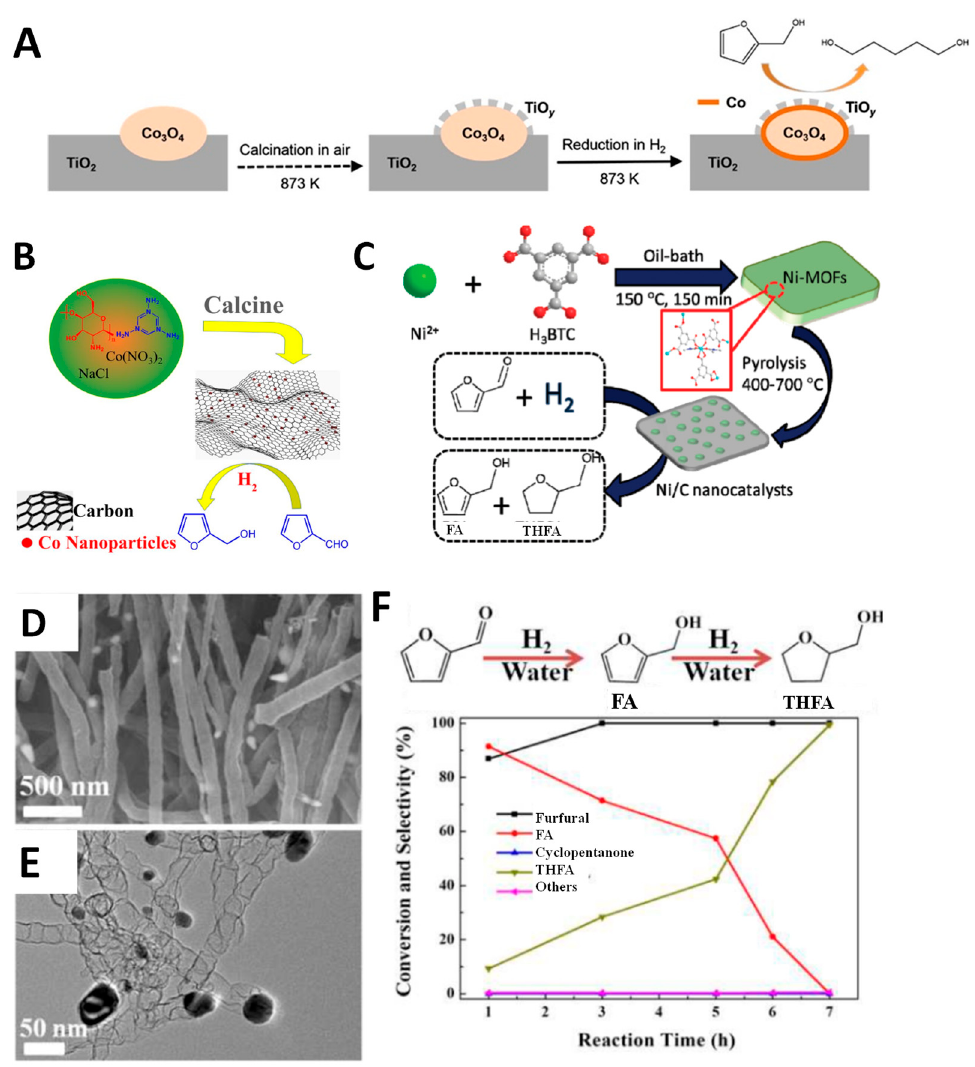
Figure 4. ( A ) Schematic illustration of the synthetic approach for Co / TiO 2 catalyst and its application in furfural hydrogenation. Reprinted with permission from [138]. Copyright 2015 Elsevier. ( B ) Co based catalyst over nitrogen-doped porous carbon support for selective hydrogenation of furfural to FA. Reprinted with permission from [82]. Copyright 2018 Elsevier. Ni Nanoparticles Encapsulated in N-Doped Carbon Nanotubes, ( C ) Synthesis of Ni / C catalysts for hydrogenation of furfural to THFA. Reprinted with permission from [70]. Copyright 2017 Royal Society of Chemistry. ( D ) SEM image, ( E ) TEM image and ( F ) e ff ect of reaction time on the hydrogenation of furfural. Reprinted with permission from [73]. Copyright 2018 Royal Society of Chemistry.